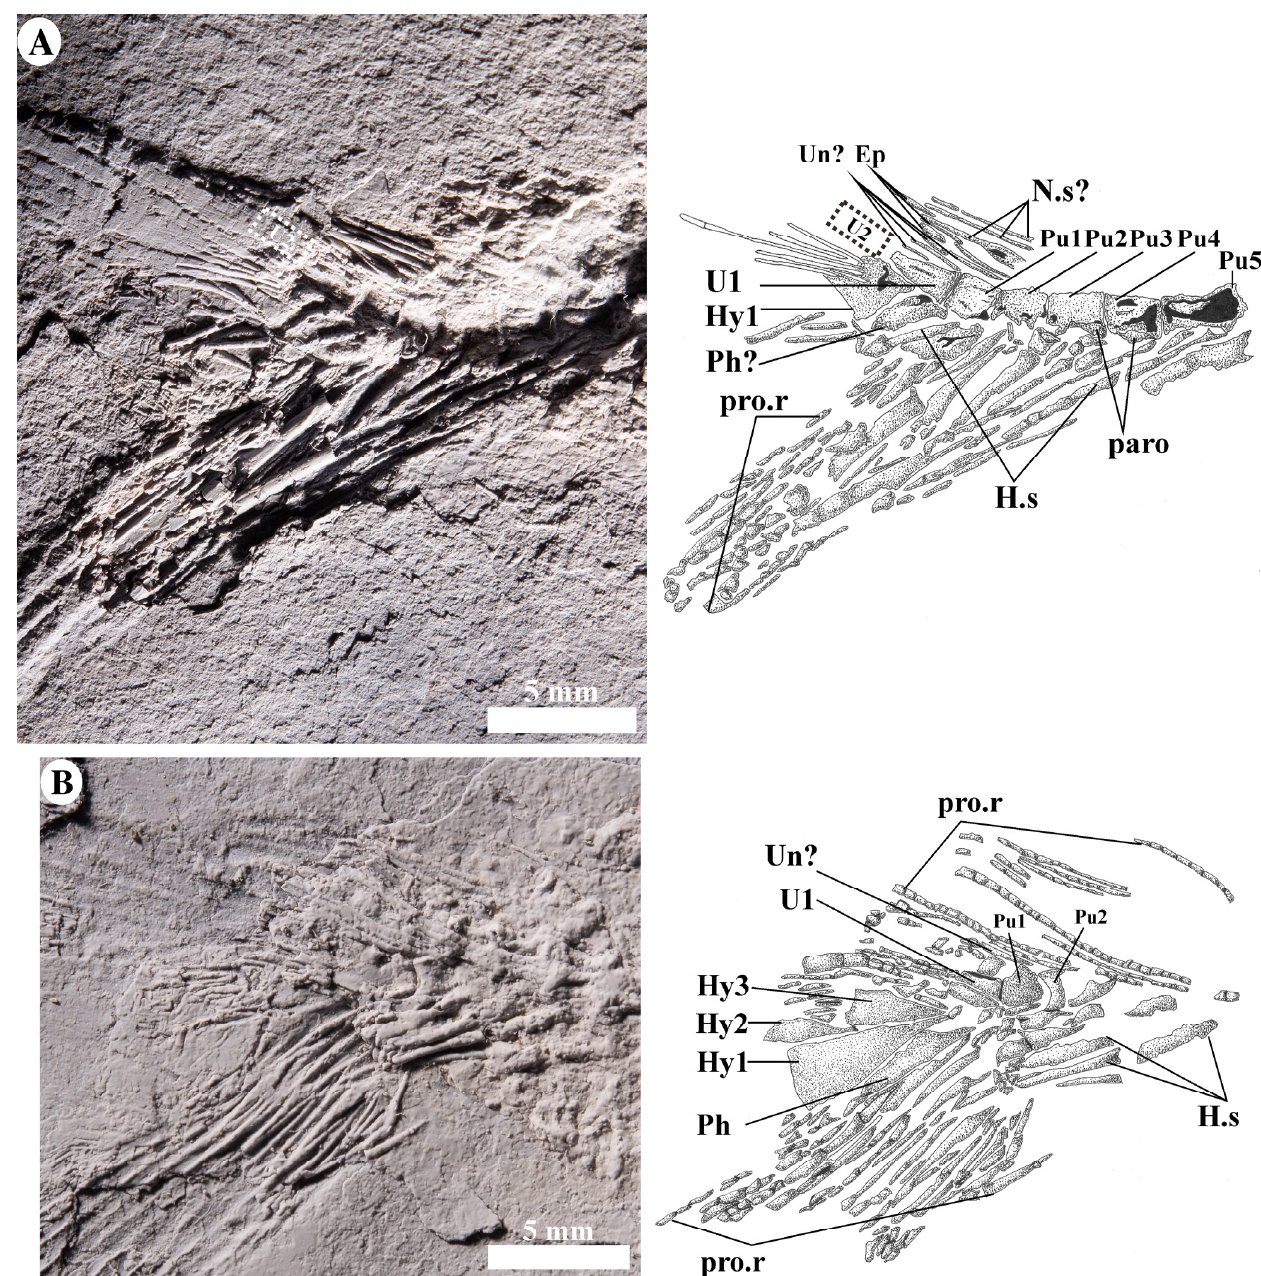
Figure 8. Caudal skeleton of † Cladocynodon araripensis gen. et sp. nov. ( A ) Photo and interpretative drawing of the exemplar CFUFMT 139 (holotype). ( B ) Photo and interpretative draw of the exemplar CFUFMT 432B (paratype).